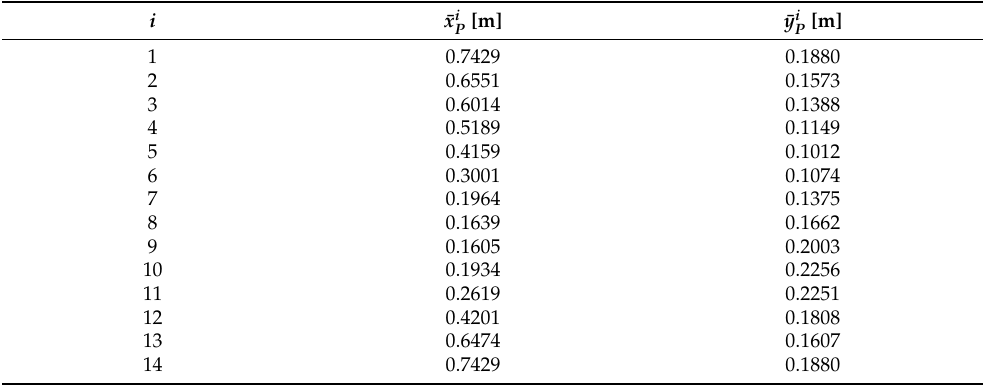
Table A1. Precision points for study case 1: Four-bar linkage mechanism.